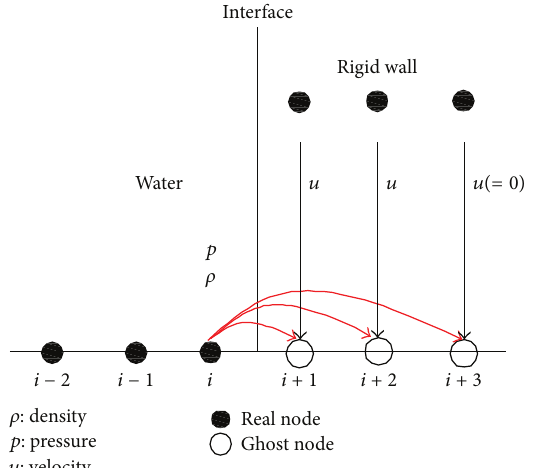
Figure 1: Illustrations for 1D GFM-based algorithm.